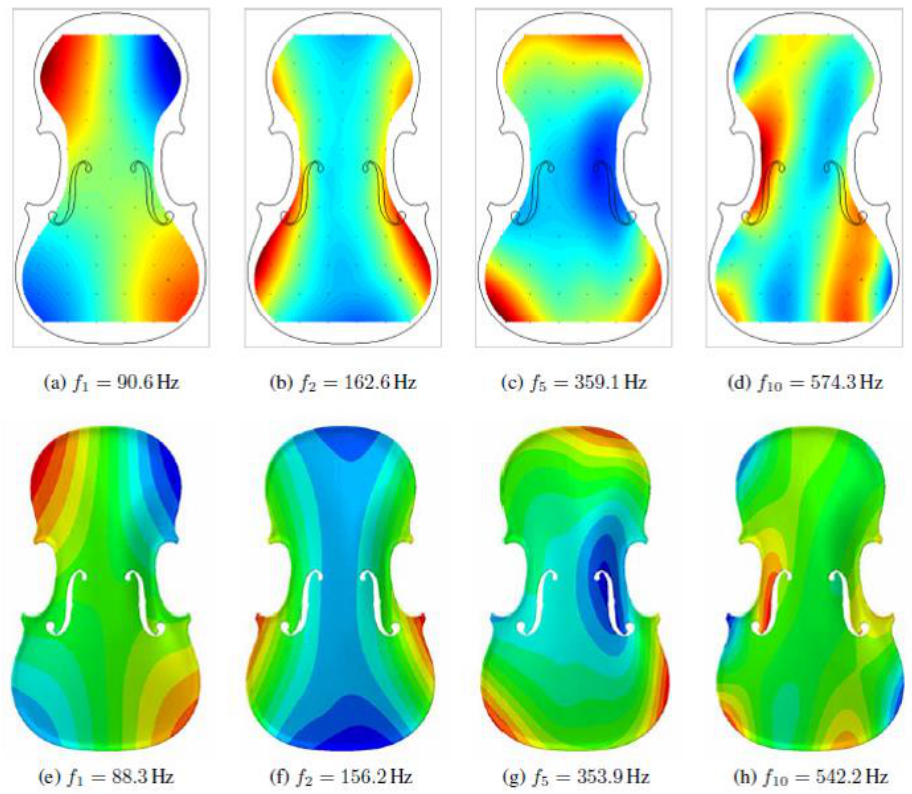
Figure 13. First, second, fifth and tenth vibration modes of the free soundboard from the experimental data (upper part of the image, ( a – d )); same mode evaluated through the FEA (lower part of the image, ( e – h